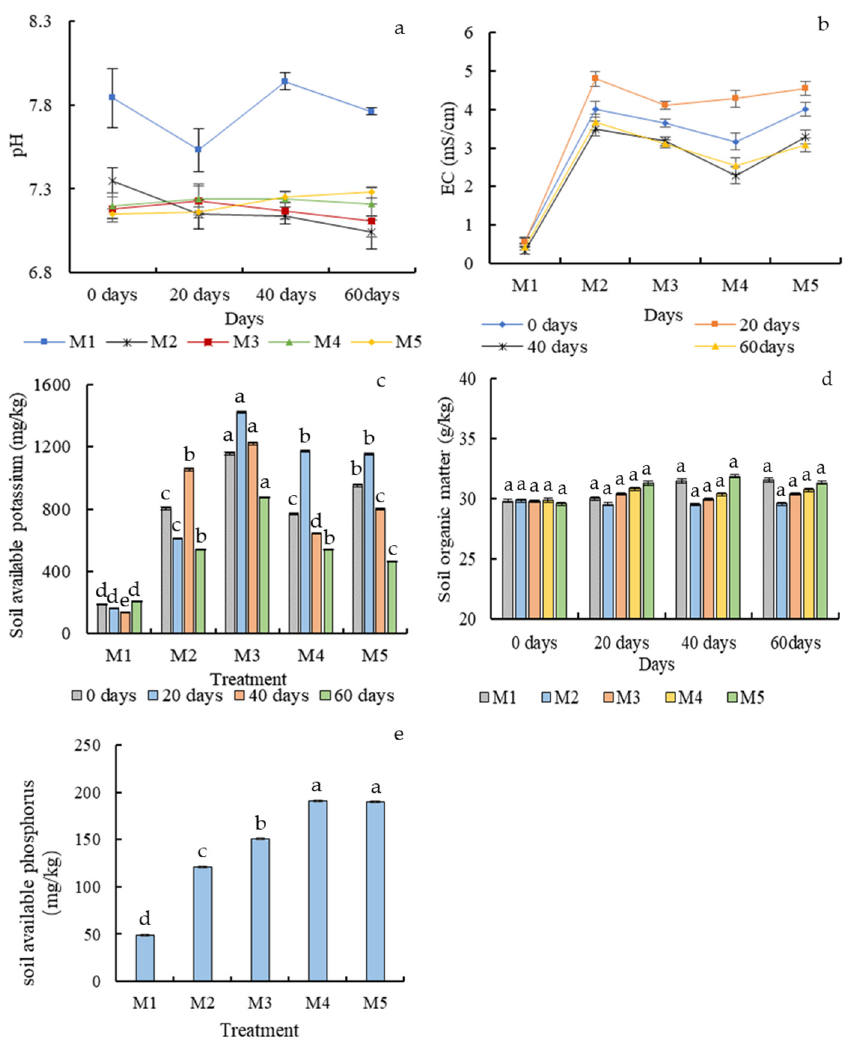
Figure 5. Changes in soil pH ( a ), EC ( b ), available potassium ( c ), and organic matter ( d ) in different treatments at different growth times. Changes in soil available phosphorus ( e ) in different treatments at harvest (60 days). Different letters in the same column indicate statistically significant differences among the samples based on one-way ANOVA (LSD, p < 0.05).